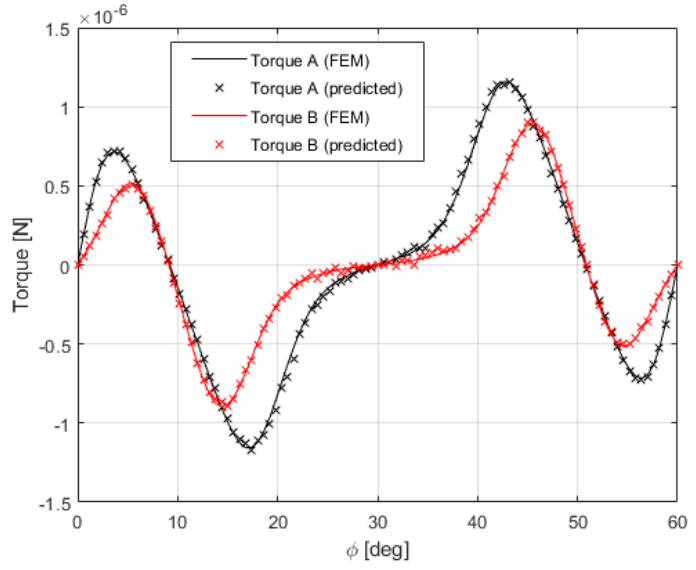
Figure 5. A comparison between true ( line ) and predicted ( cross ) torque profiles: two geometries (device A and B) are considered.